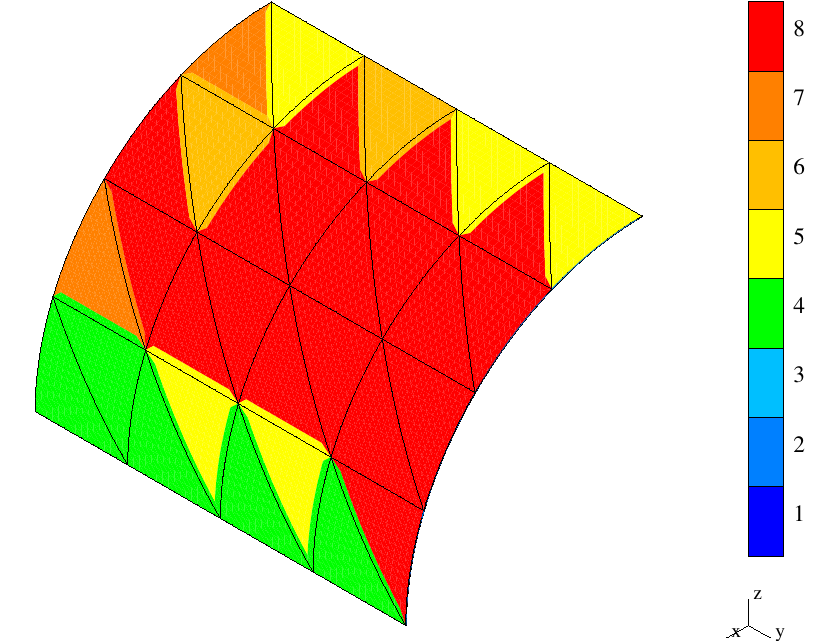
Figure 22. A quarter of a bending-dominated shell— hp -adapted (final)